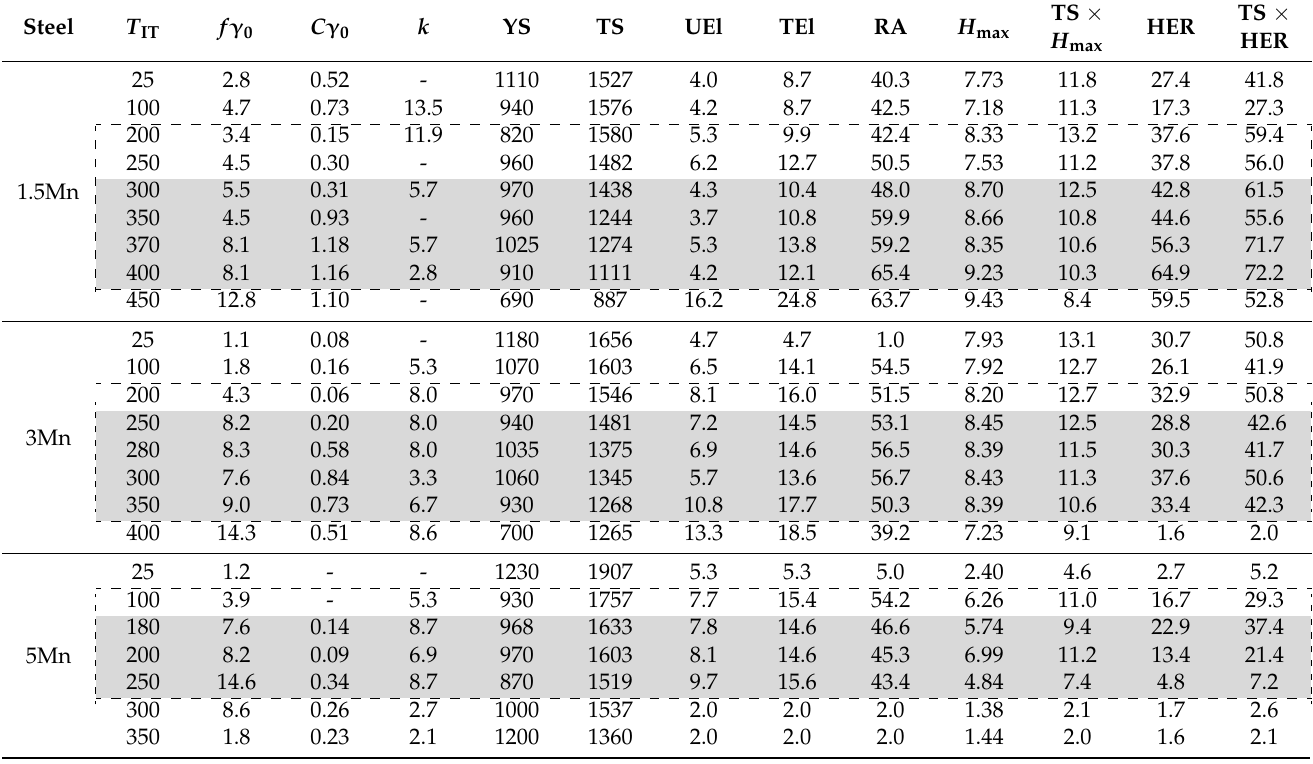
Table 2. Retained austenite characteristics, tensile properties, stretch-formability, and stretch-flangeability of the 1.5Mn, 3Mn, and 5Mn steels subjected to the IT process. Gray color zones correspond to IT temperatures between M s and M f of the steels. Dotted frames correspond to the IT temperatures between M s and M f − 100 ◦